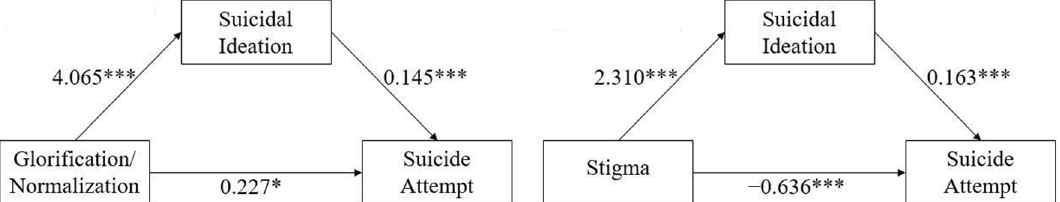
Figure 1. The mediation model of suicidal ideation in the association between glorification/normalization of suicide ( left ) and stigma toward suicide ( right ) and suicide attempts. * p < 0.05, *** p < 0.001.